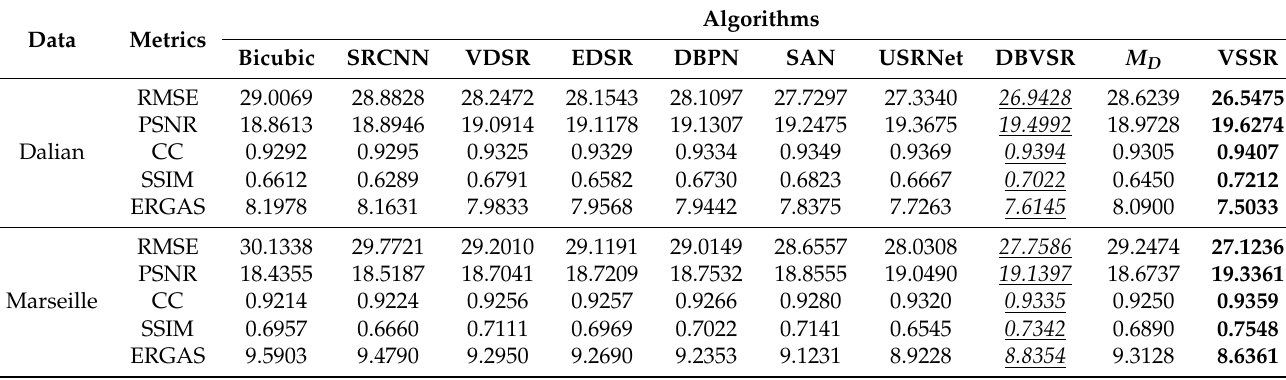
Figure 11. Comparison of the average inference time for reconstructing the San-ya scene from the Jilin-1 data. ( a ) compares the average inference time of different methods. ( b ) compares the average inference time of each module in the VSSR for reconstructing the San-ya scene with size 1280 × 1280. ( a ) Average Inference Time of Different Methods. ( b ) Average Inference Time of Each Module. Table 3. Quantitative evaluation of the proposed VSSR against different methods on the OVS-1 data with scale factor of 4, Bold indicates the best and italic underline indicates the second-best